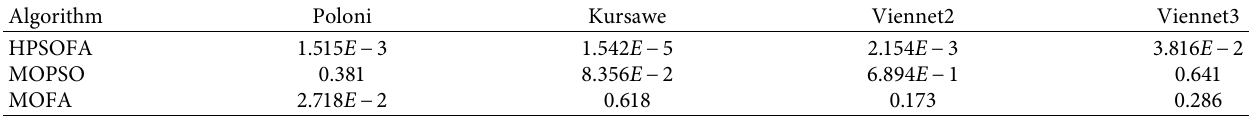
Table 2: IGD evaluation index.